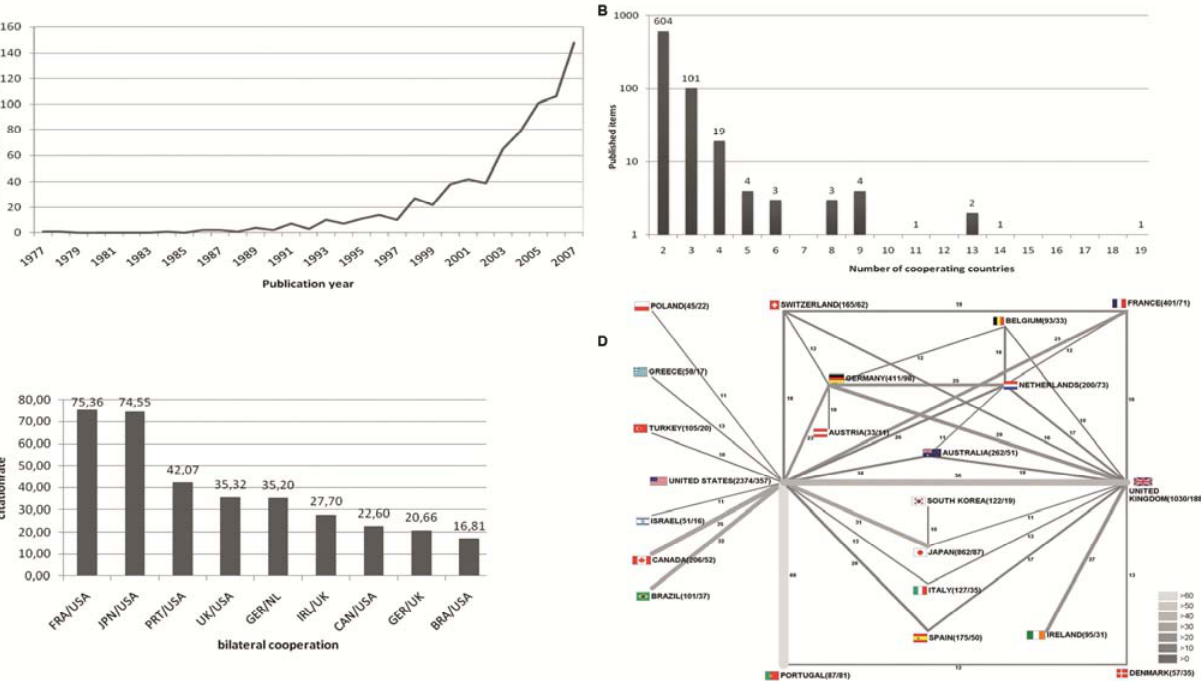
Figure 3. Country network analysis. ( A ) Evolution of international cooperation since 1977. ( B ) Total numbers of published items with authors originating from two, three or more countries (bi-, tri , and multilateral cooperation). ( C ) Bilateral cooperation with the highest citation rate. ( D ) Spider chart visualizing bilateral networking between countries for the overall number of collaborations between the two countries. Size and color of bars encode the number of bilateral cooperation. For a less crowded synoptic view a threshold of at least twelve cooperations per country for was set in the